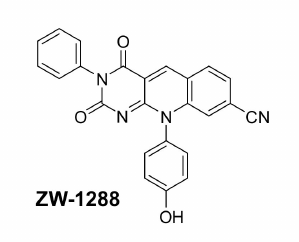
Figure 4. The molecular structure of